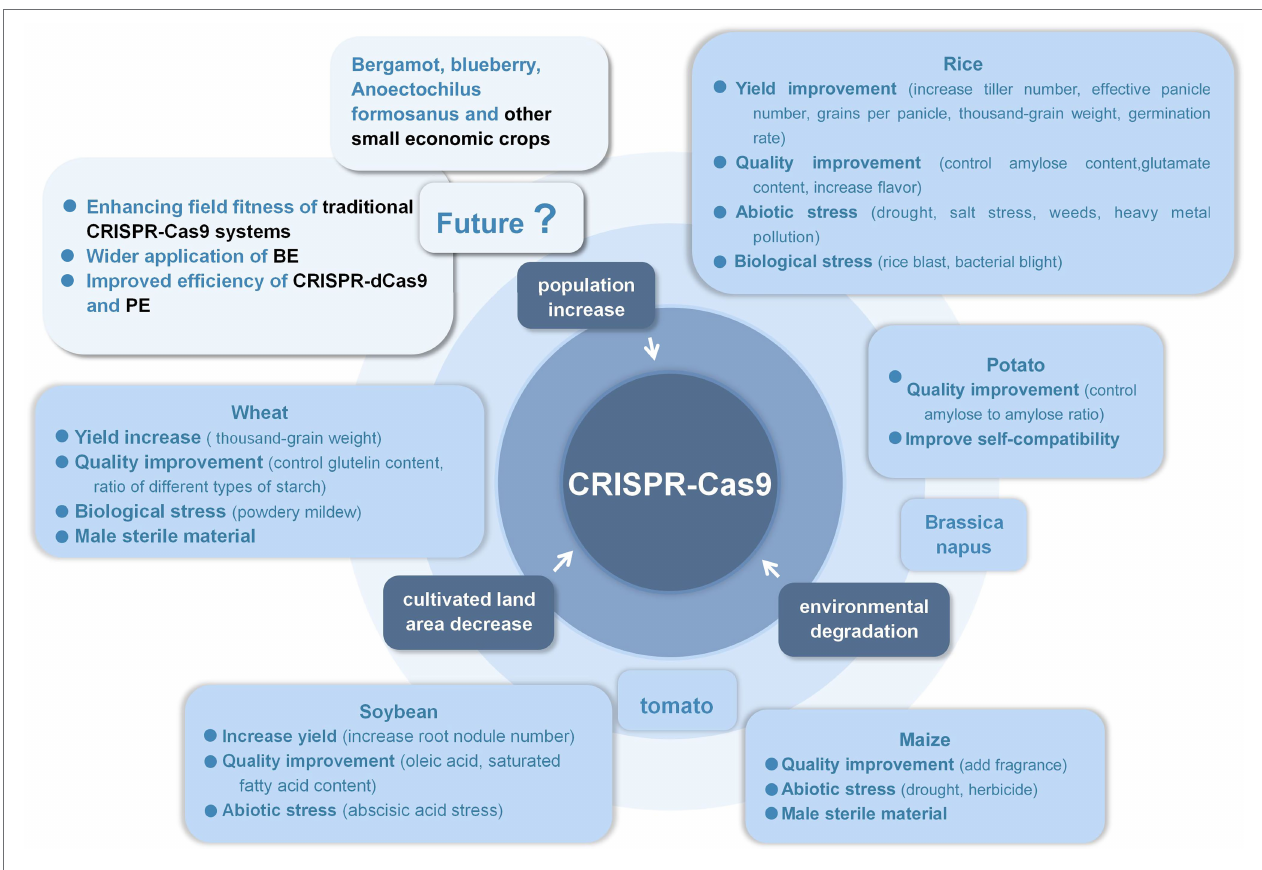
FIGURE 1 | The prospects of CRISPR-Cas9 in crop